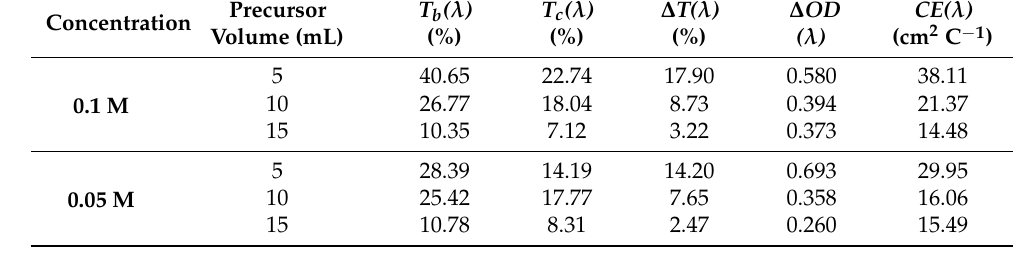
Table 2. Optical and electrochromic properties of the WO 3 films at λ = 700 nm.